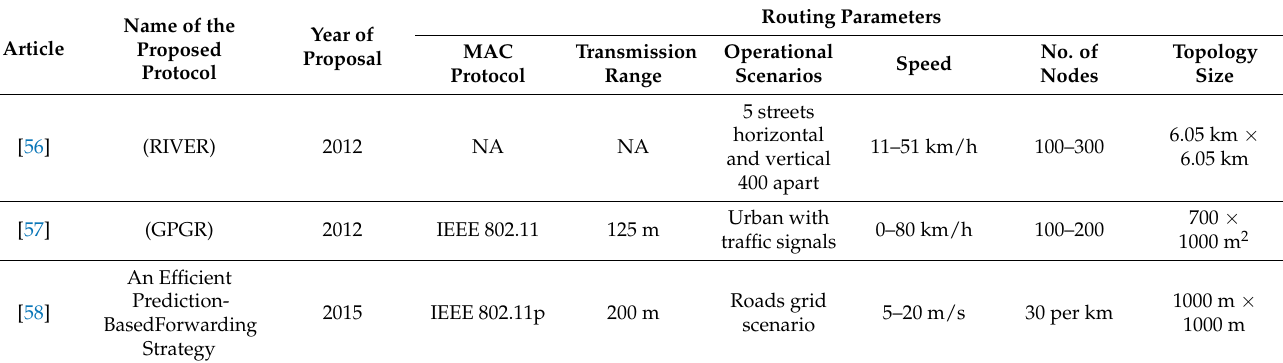
Table 17. Routing parameters of grid scenario-based routing